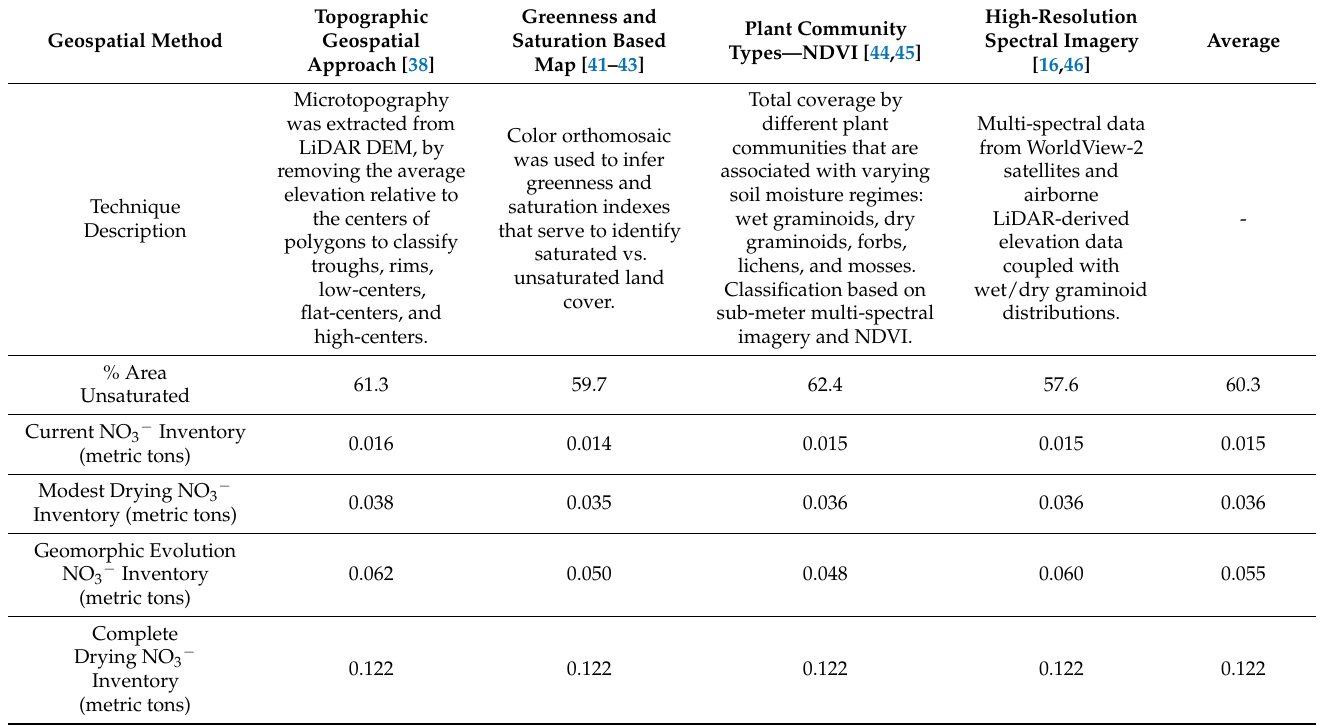
Table A2. Compilation of the remote-sensing geospatial approaches used to upscale our experimental NO 3 − concentration and soil moisture data to the larger BEO to predict current and potential future NO 3 − inventories (see Appendix A.3. for more in-depth method details). Predicted area percent coverage of unsaturated regions within our study site is listed for each geospatial approach. NO 3 − inventories calculated using each geospatial approach are displayed, calculated by Equation (1), using the median NO 3 − concentration data and soil moisture content data distribution values for each polygonal feature identified. Averages of estimations provide bounds on possible saturated versus unsaturated areas as identified by the different geospatial